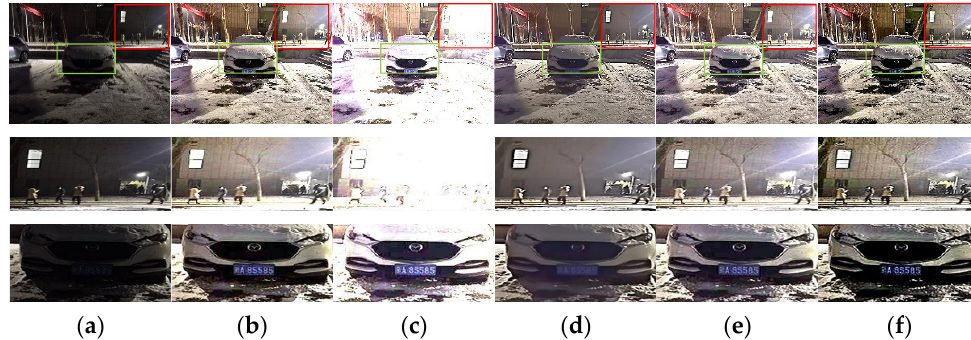
Figure 13. ( a ) Test image and its detail maps. The remaining images are the enhancement results and their detail maps, generated by the following methods: ( b ) ALSM, ( c ) Li et al. [26], ( d ) LR3M, ( e ) LIME, and ( f ) the proposed method.